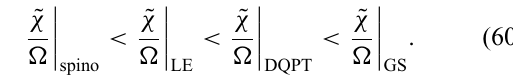
FIG. 6. (a) Phase portrait of the phase-space flow of the 3TaT Hamiltonian at critical coupling. The separatrix is shown in solid red. (b) Metrological gain based on the QFI (solid red), at critical coupling, for an initial SCS centered at the position of the saddle point. The dashed line shows our result for the time to the first peak. Results are for a system with N = 1024. (c) Time scale to the first peak of the QFI with 3TaT at critical coupling, contrasted against the Ehrenfest